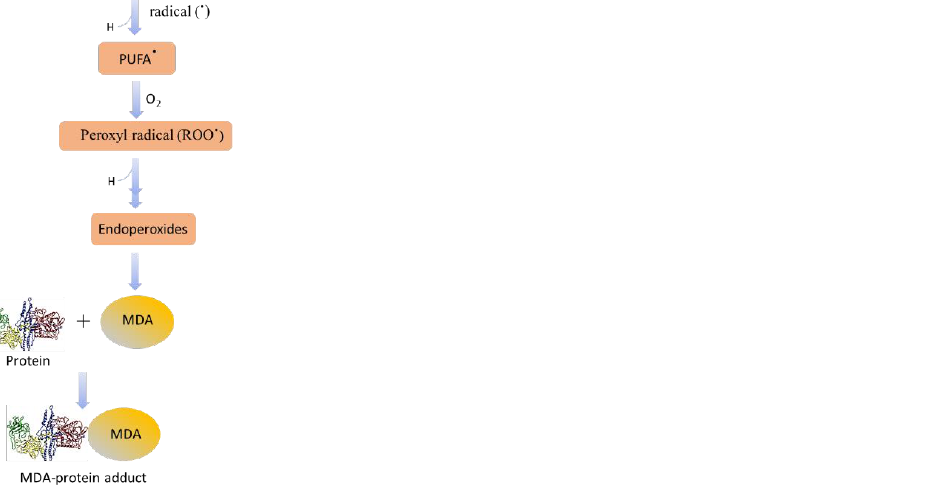
Figure 8. Schematic representation showing the steps involved in protein modification as the results of ROS generation and successive oxidative radical reactions.